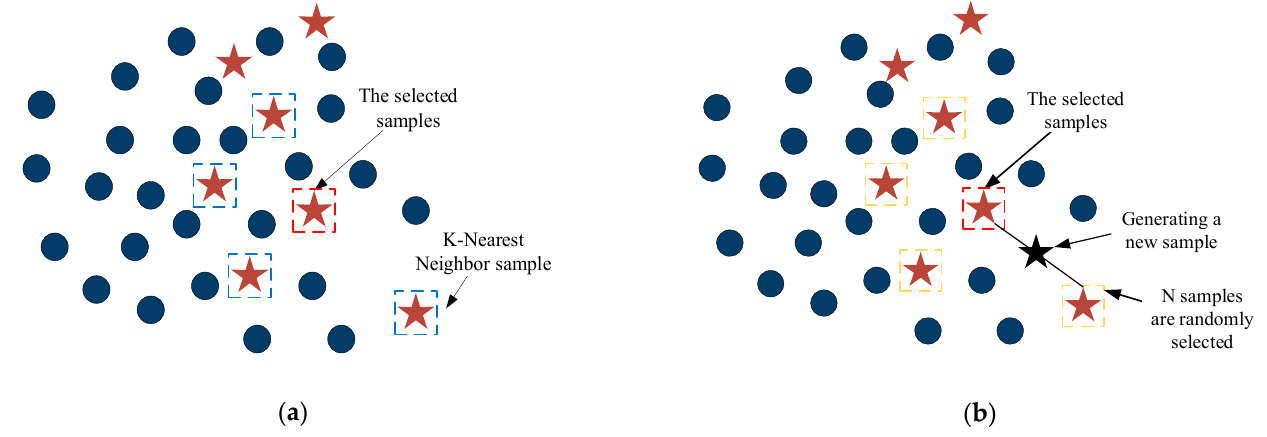
Figure 1. ( a ) Calculating the proximity of the selected sample K; ( b ) Synthesizing new samples.